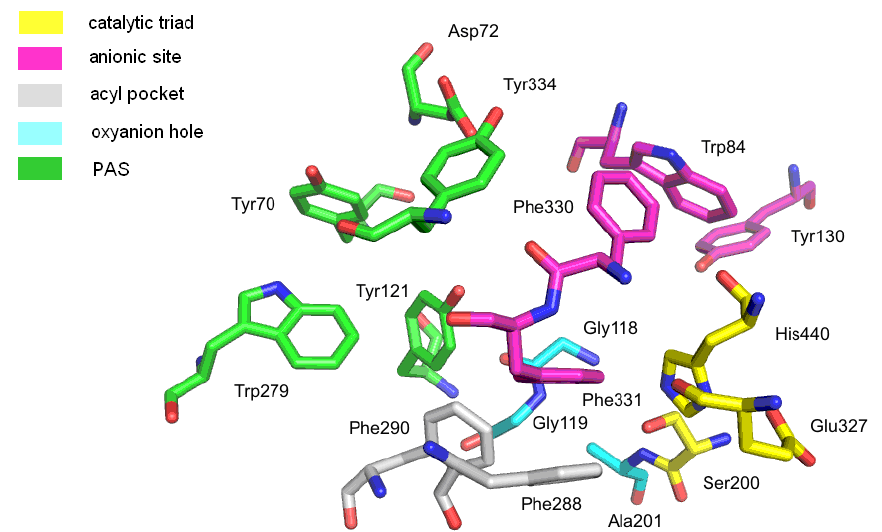
Figure 2. Active site of acetylcholinesterase ( Torpedo californica acetylcholinesterase (TcAChE); Protein Database Bank (PDB): 1EVE).